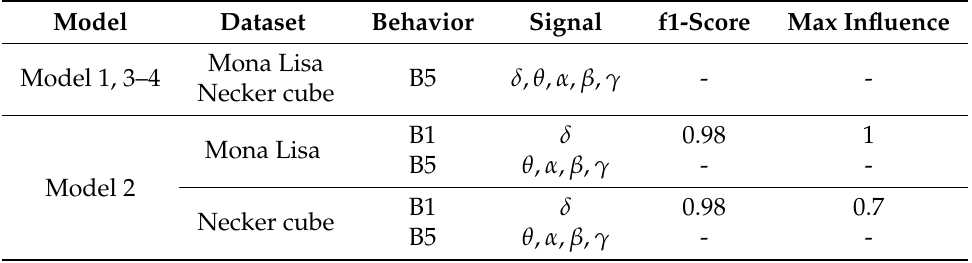
Table 14. The results of using the models with FTRL optimizer for intensity classification.